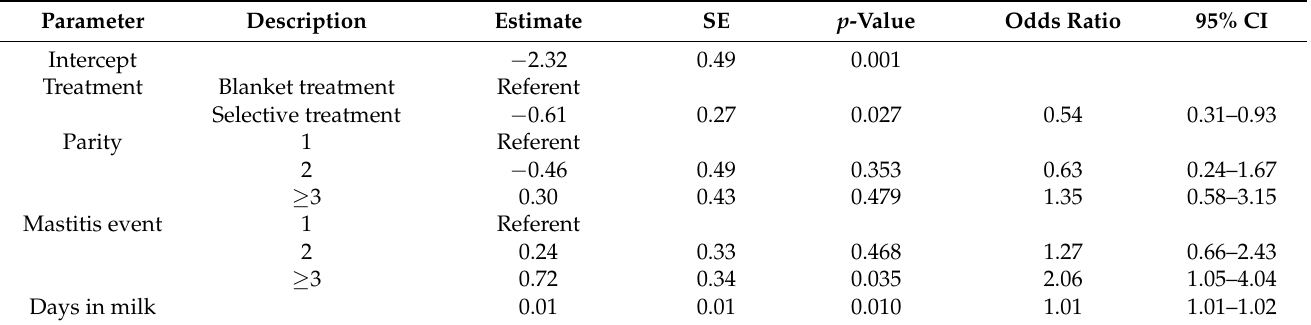
Table 2. Logistic regression for survival to 60 d after clinical mastitis event 1